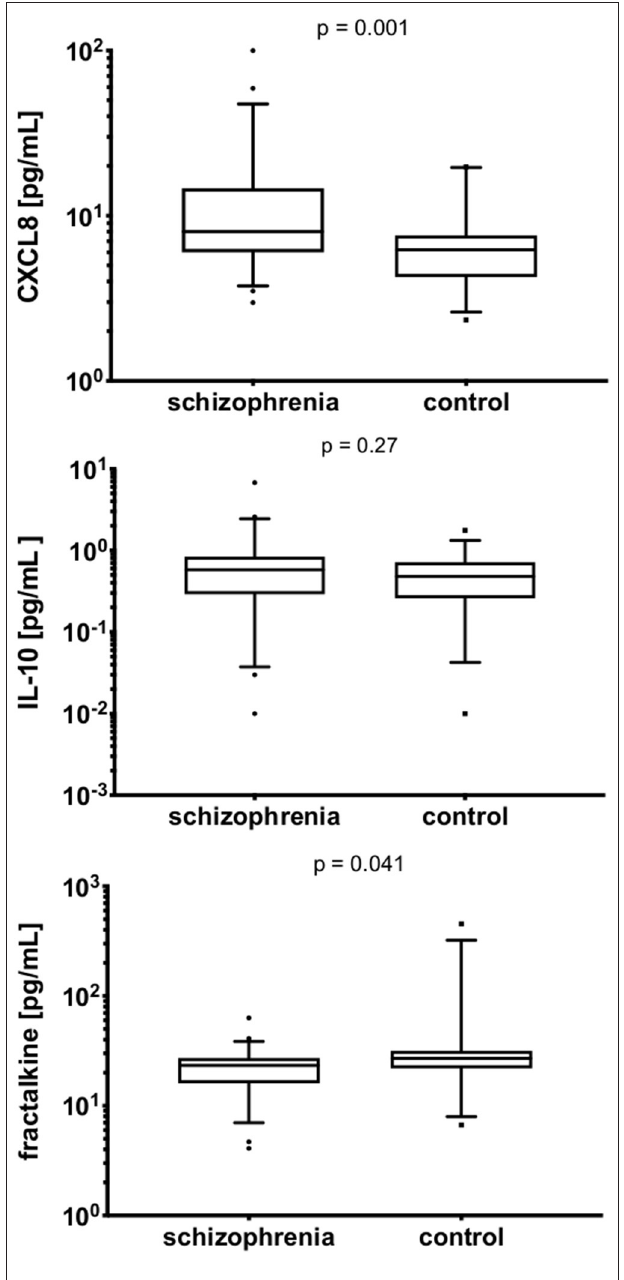
FIGURE 1 | The comparison of serum CXCL8, IL-10, and fractalkine in the schizophrenia and control groups. Y axes are log10 scaled. The boxes extend from 25 to 75th percentiles, the lines in the middle of the boxes represent medians. The whiskers extend from 10 to 90th